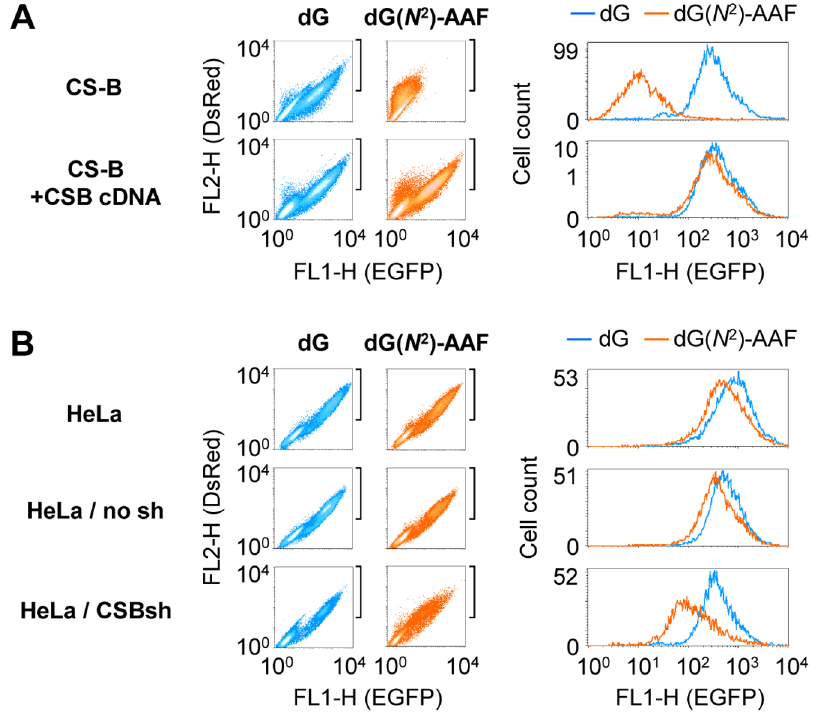
Figure 2. Modulation of the effect of dG( N 2 )-AAF by CSB. Host cell reactivation of the EGFP expression in pairs of isogenic cell lines with different CSB expression statuses. Cells were transfected with constructs containing a unique dG( N 2 )-AAF (amber colors) or dG (blue colors) in the transcribed strand of the EGFP gene. Cells were selected according to the expression of DsRed as a transfection marker (the gated region shown by square brackets near the dot density plots) to generate the overlaid fluorescence distribution plots (on the right). (A) The effect of complementation of the CSB deficiency by expression of the CSB cDNA. (B) The effect of CSB knockdown by expression of the specific shRNA (CSBsh). See also Figures S3 and S4.